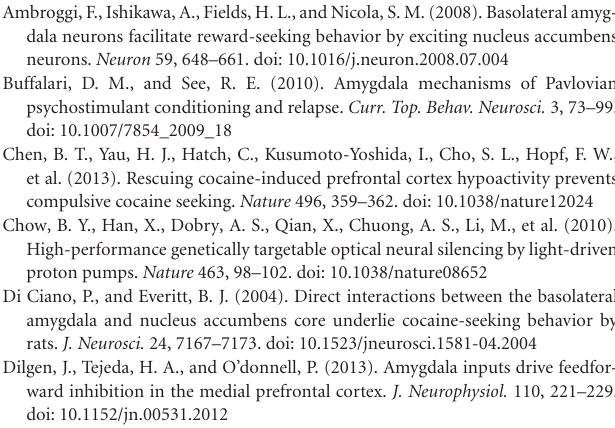
FIGURE 4 | Location of fiber optic terminations in the BLA, NAcore, and PL for each experiment . Triangle shape shows the approximate predicted perimeter of light diffusion in the brain. The apex of the triangle corresponds with the histologically identified ventral termination of the fiber optic and the triangle illustrates the approximate size of the illuminated tissue.